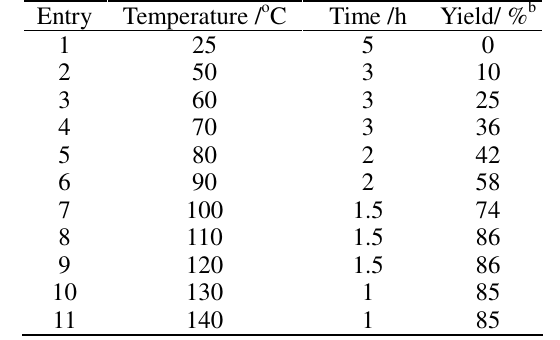
Table 1. Temperature optimization for the synthesis of synthesis of 7-phenyl-6 H ,7 H